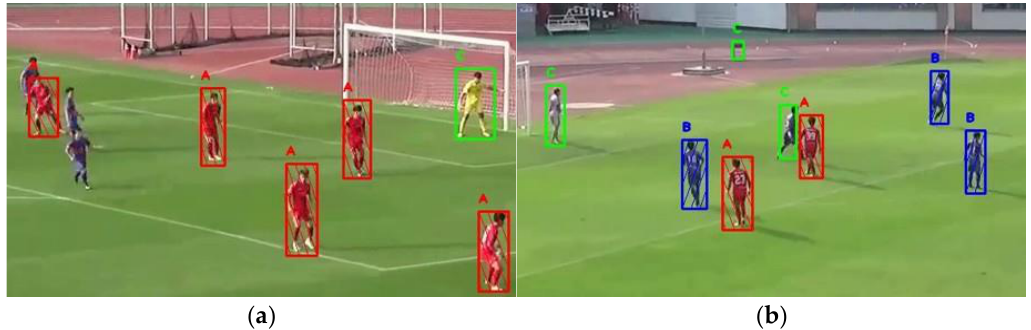
Figure 4. Examples of object recognition errors due to limited feature information: ( a ) Missing object recognition; ( b ) Incorrect object recognition.